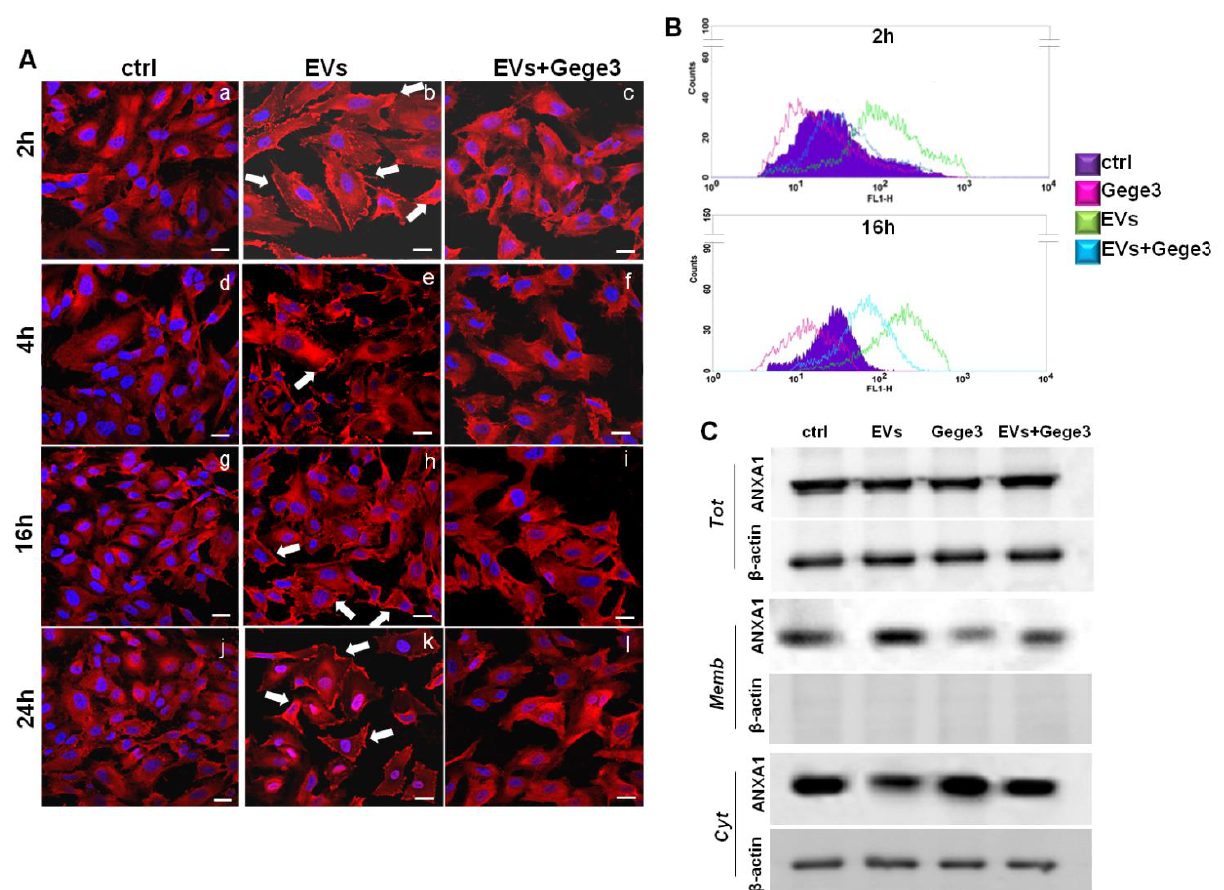
Figure 3. Evaluation of Gege3 effects on MIA PaCa-2 cells deriving EVs. ( A ) Confocal analysis for ANXA1 on HUVEC cells treated or not with EVs with and without Gege3 10 µM for 2 (panels a – c), 4 (panels d – f), 16 (panels g – i), and 24 (panels j – l ) hours. Magnification 63 × 1.4 NA. Bar = 100 μm. ( B ) Cell surface expression of ANXA1 was analyzed by flow cytometry. The violet area in the plot is relative to not treated cells; the ANXA1 signal is shown in green after treatment with MIA PaCa-2 EVs, in pink with Gege3 10 µM, and in light blue with both of them for 2 and 16 h. ( C ) Whole, membrane, and cytosol expression of ANXA1 in HUVEC cells treated or not for 8 h with PC EVs and Gege3 10 μM taken alone or together, analyzed by Western blot. Protein normalization and the check of the sample quality were performed on β -actin levels.